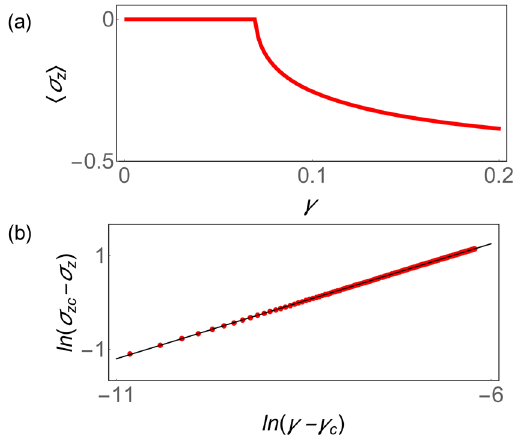
Figure 1. Quantum Phase transition in a Non-Hermitian LMG model. ( a ) The average magnetization along z axis, 〈 σ z 〉 = 〈 J z 〉 / N , as a function of γ in the LMG model with N = 40 spins. ( b ) Scaling of the magnetization around the critical point. The vertical axis plots σ σ − ln( ) with 〈 σ z 〉 c being the average of σ z at the critical z c z point. The horizontal axis is γ γ − ln( ) , where γ c is the critical control parameter. The red solid circle presents c the numerical exact solution and the black solid line is the linear fitting line, where the slope is 0.49 ±